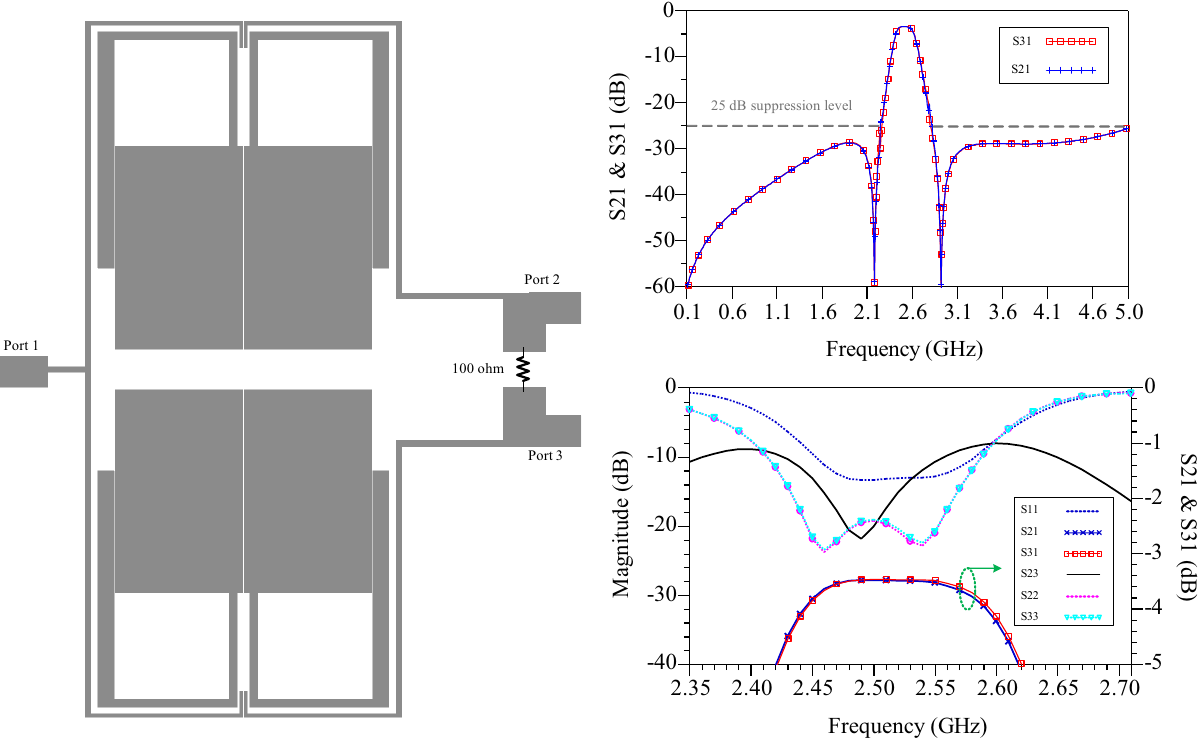
Figure 8. Narrow-band WPD proposed circuit and its S-parameter